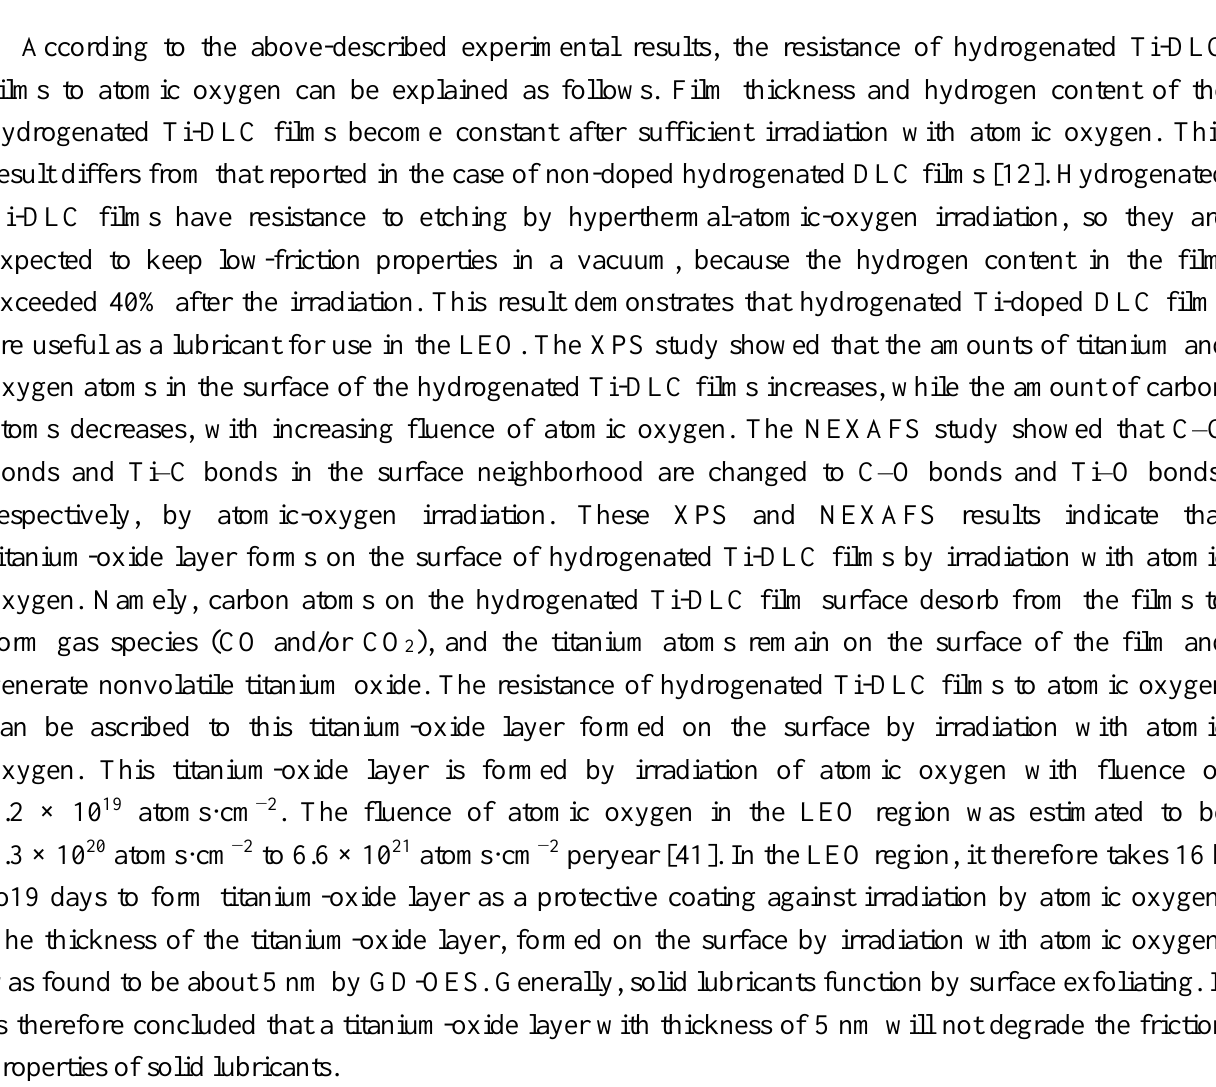
Figure 10. Element analysis (in depth direction) of oxygen in Ti-DLC